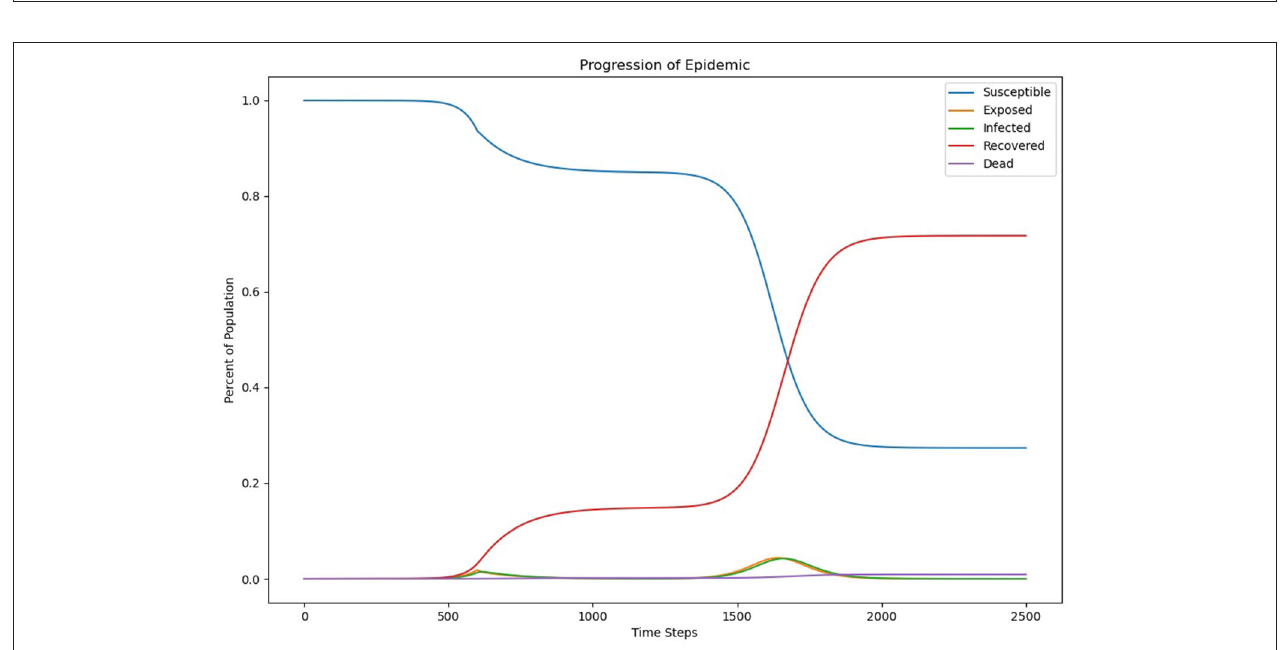
FIGURE 2 | Epidemic progression with ρ =